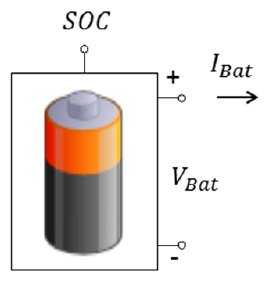
Figure 7. PSIM battery model.